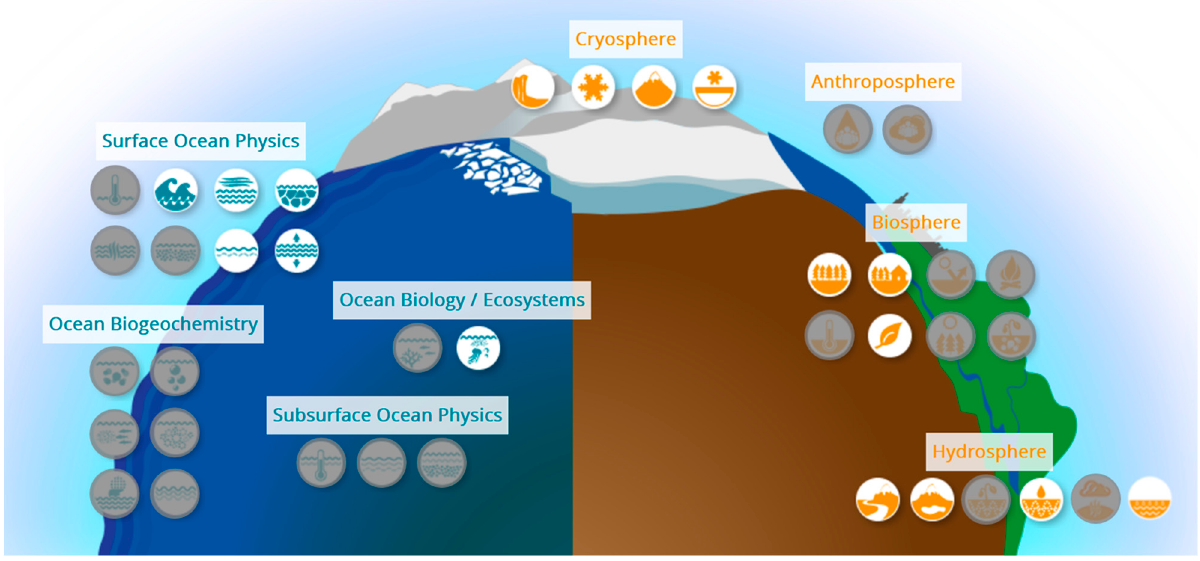
Figure 4. Environmental climate variables that can be measured by GNSS-R: (from left to right) Sea state, surface stress, sea ice, surface currents, sea level, plankton, ice sheets, snow, glaciers, permafrost, above-ground biomass, land cover, leaf area index, river discharge, lakes, soil moisture, and terrestrial water storage. Adapted from the global climate observing system (GCOS) [https://gcos.wmo.int/copyright accessed on 16 April 2023] under CC-BY-4.0.